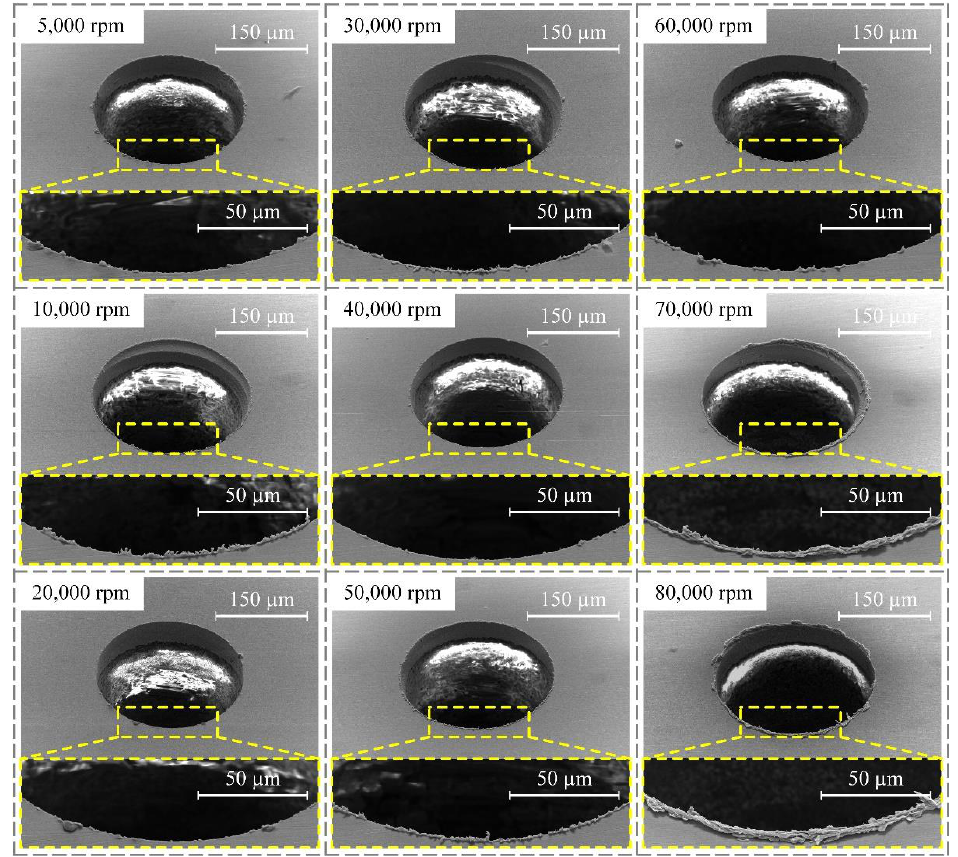
Figure 4. Influence of spindle speed on the quality of micro-hole mouth.